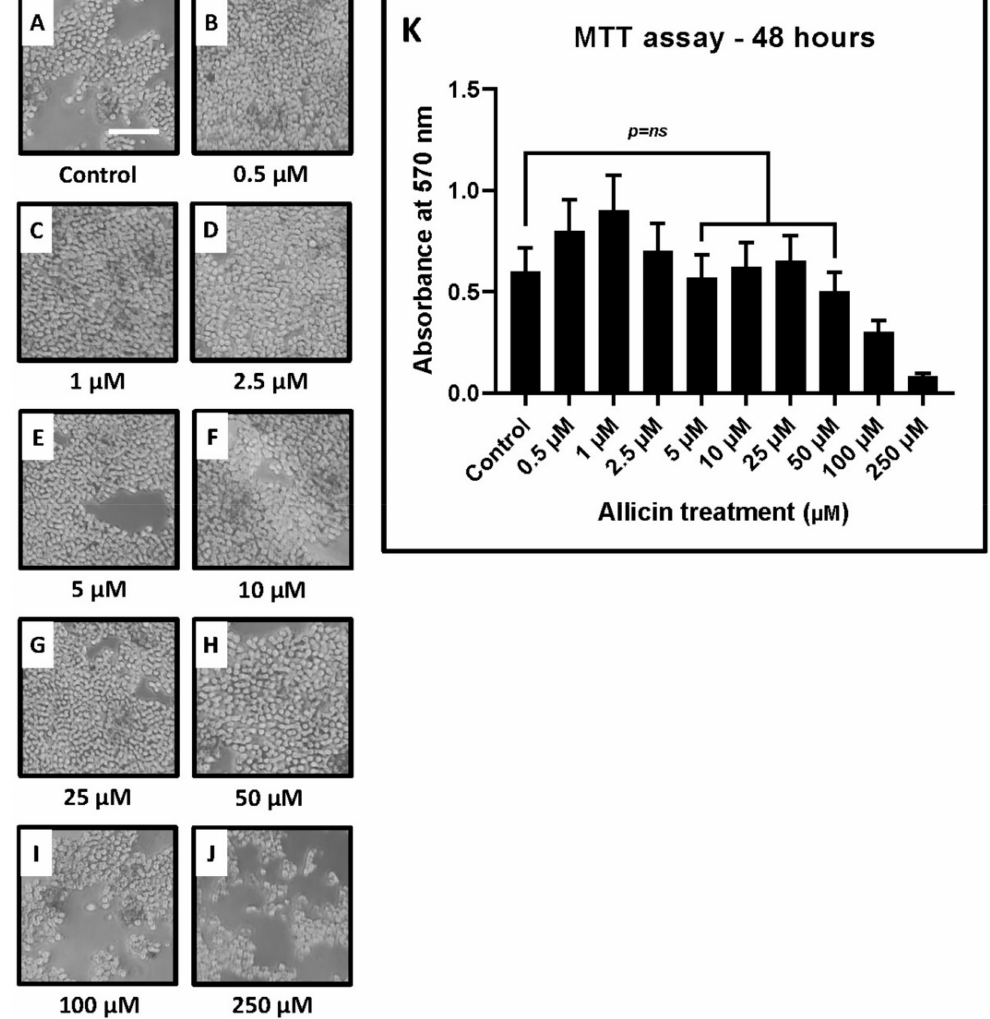
Figure 3. MTT assay depicting the influence of various concentrations of allicin on human CD3+ lymphocytes. Treatment of sorted CD3+ T lymphocytes with different concentrations of allicin and MTT assay for assessment of the viability of the treated cells. ( A – J ) Micrographs of CD3+ T lymphocytes treated with various concentrations of allicin (0.5, 1, 2.5, 5, 10, 25, 50, 100, and 250 µ M). Scale bar = 100 µ m. ( K ) Comparative cell viability in CD3+ T lymphocytes treated with various concentrations of